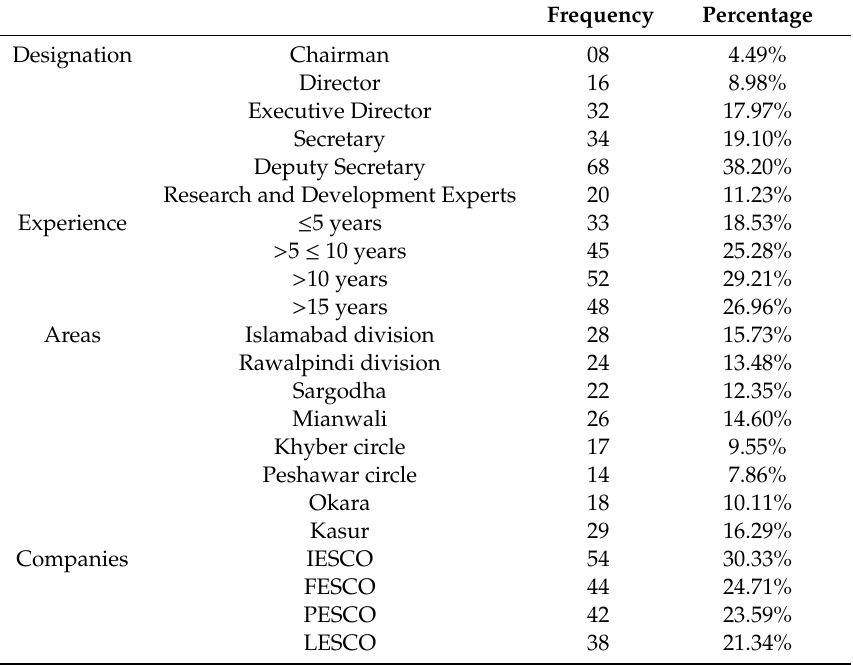
Table 2. Respondents’